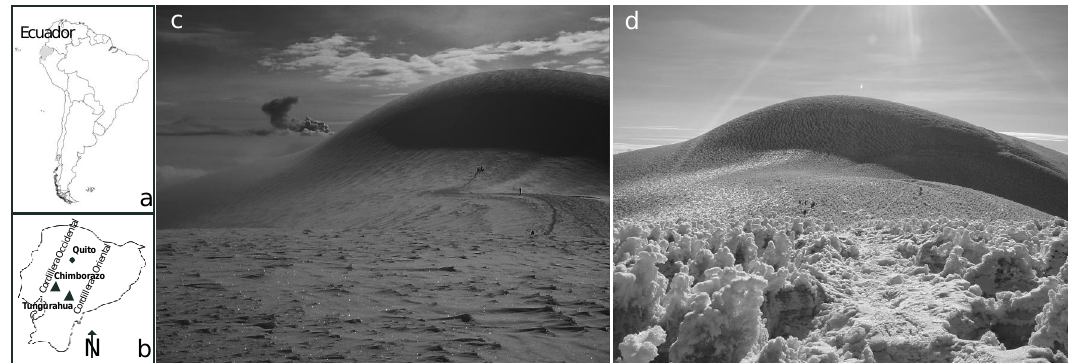
Figure 1 Fig. 1. Map of South America (a) and Ecuador (b) , showing the location of Chimborazo and Tungurahua summits. Views of Chimborazo Cumbre Whymper (6268m) and middle plateau from Cumbre Ventimilla (6230m) in 1999 (c) and 2000 (d) . A smooth snow surface was encountered in December 1999, whereas the Tungurahua eruption (ash plume visible in the background) transformed the glacier surface, which was completely covered with ash, penitents and hoarfrost in December